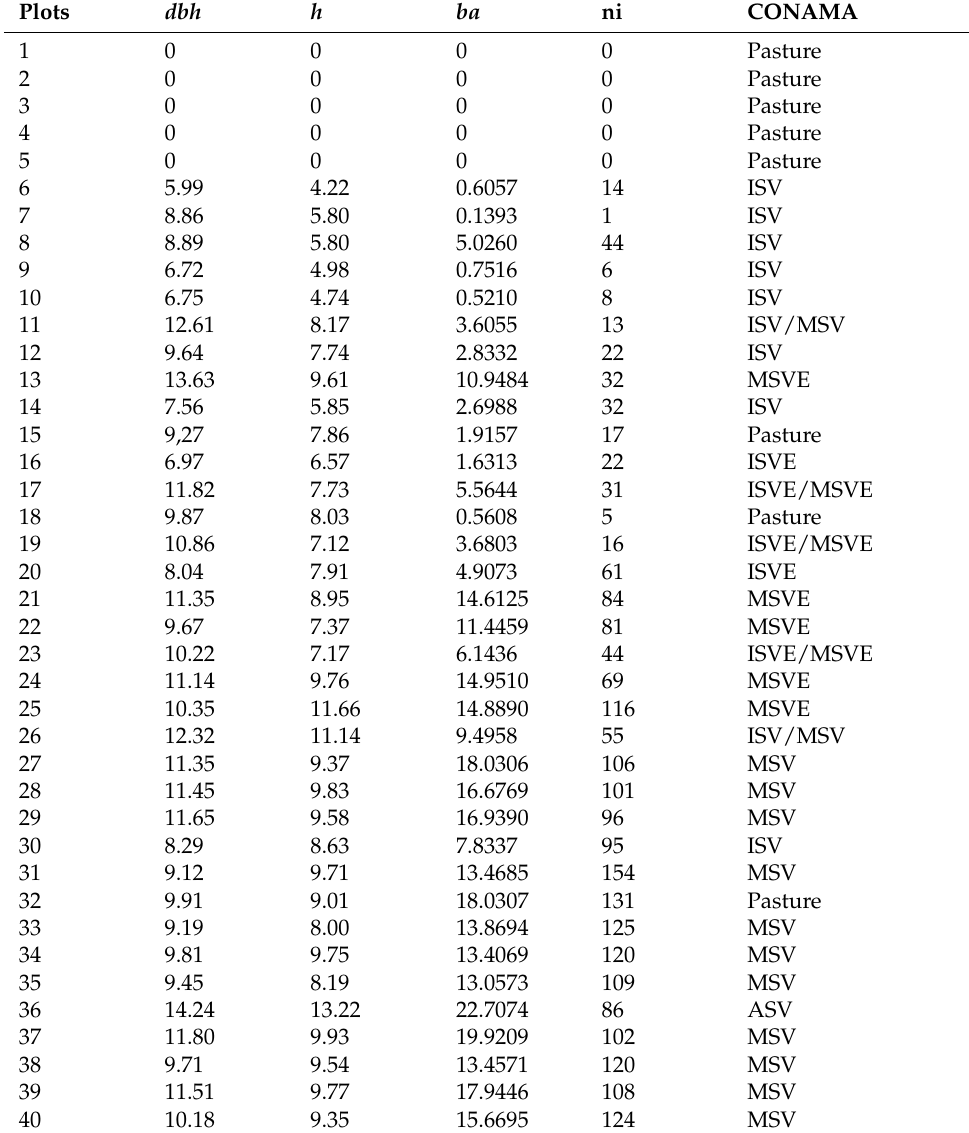
Table 4. Parameters observed in TFI and classification according to